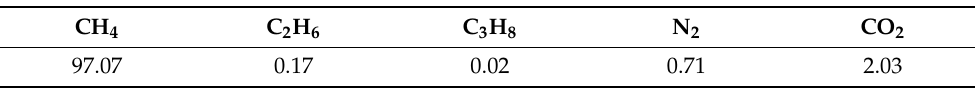
Table 5. Components of the studied natural gas.